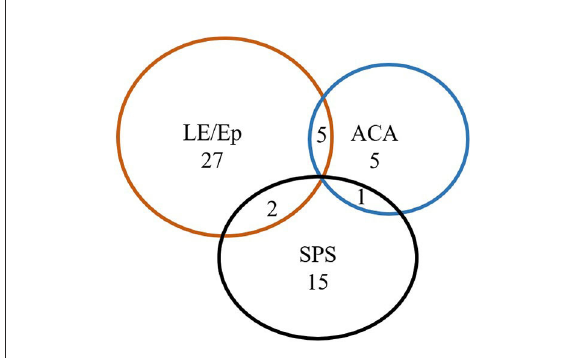
FIGURE1 Neurological autoimmunity associated with anti-GAD65 antibodies. LE, limbic encephalitis; Ep, epilepsy; SPS, stiff person syndromes; ACA, autoimmune cerebellar ataxia.